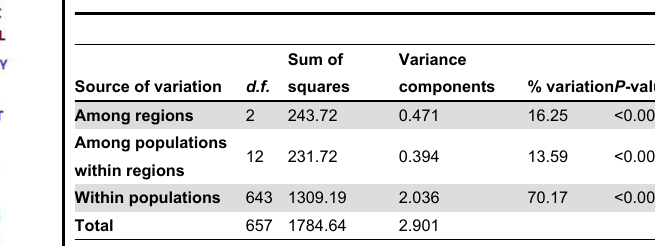
Table 4. Nested analysis of molecular variance (AMOVA) of 329 individuals in 15 populations of Solanum rostratum in three geographic regions: Mexico, the USA, and China.